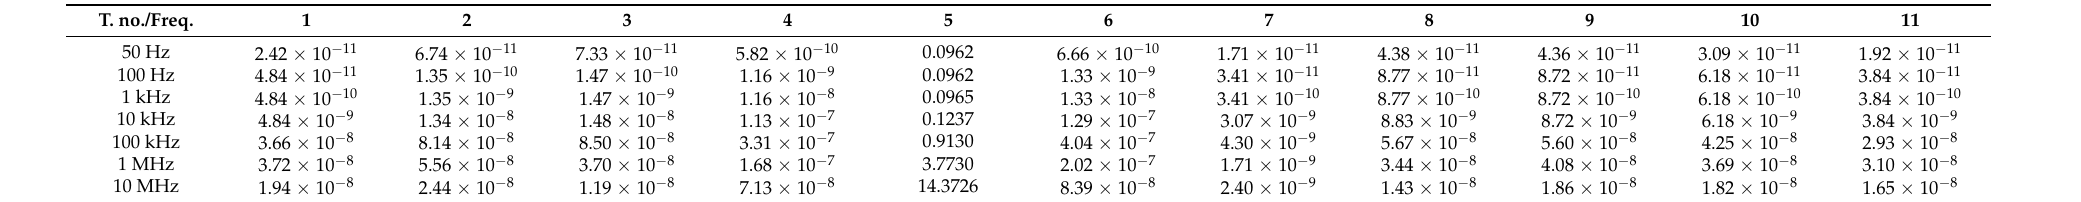
Table A14. Self and mutual resistances of turn 5 (in Ω ) resulting from FEM